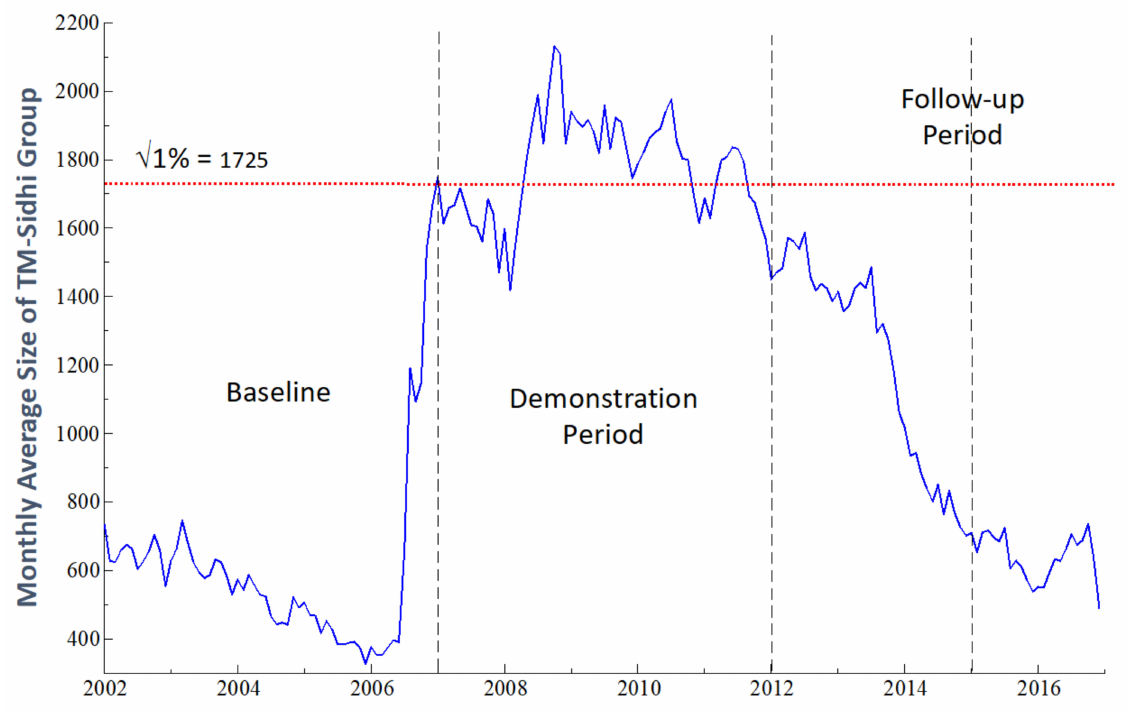
Figure 1. Monthly mean number of individuals practicing Transcendental Meditation and the advanced TM-Sidhi program together in a group at Maharishi International University, Fairfield, Iowa,